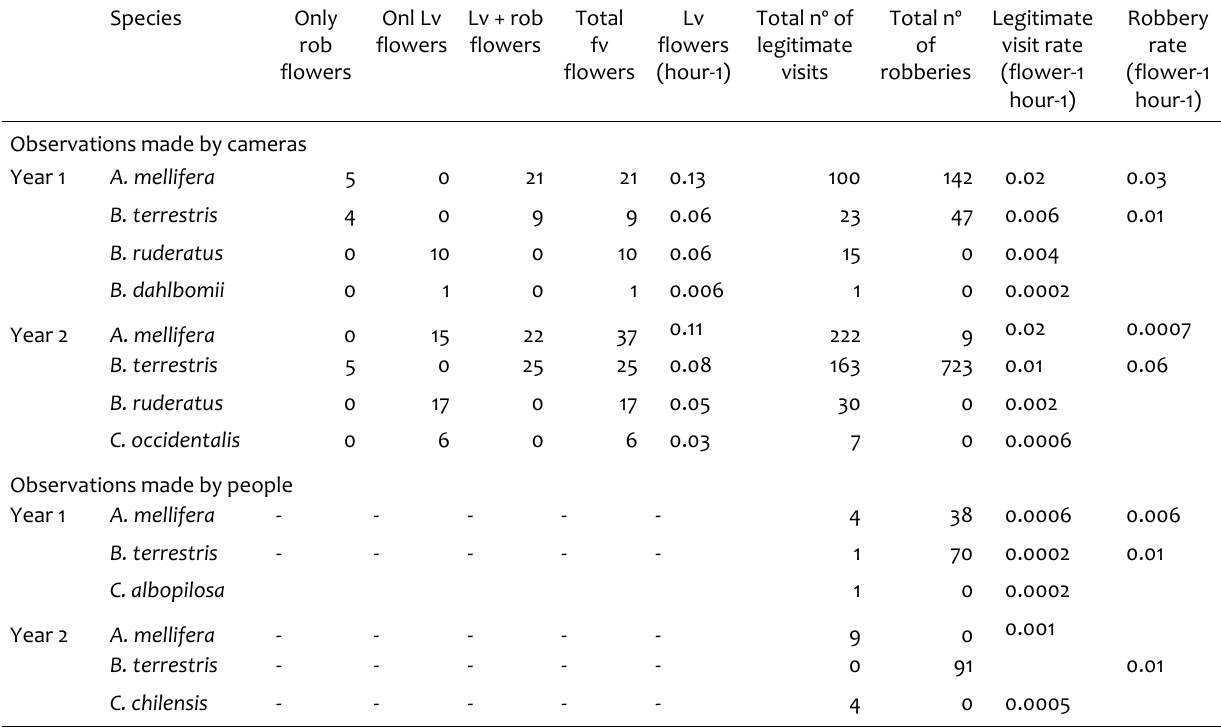
Table 1. Legitimate visits and robbery activity (when flowers are open) in a Vicia faba field. The total number of flowers in anthesis and buds recorded with cameras was 27 in 2018 and 37 in 2019. The total time recorded was 155.93 hours of anthesis in year one and 334.70 h in year two. A. = Apis , B. = Bombus , C. = Cadeguala . Lv = Legitimately visited, rob = robbed. In the observations made by on-site observer method, to standardize the visit rate, the average number of flowers per plant was 14.08 ±